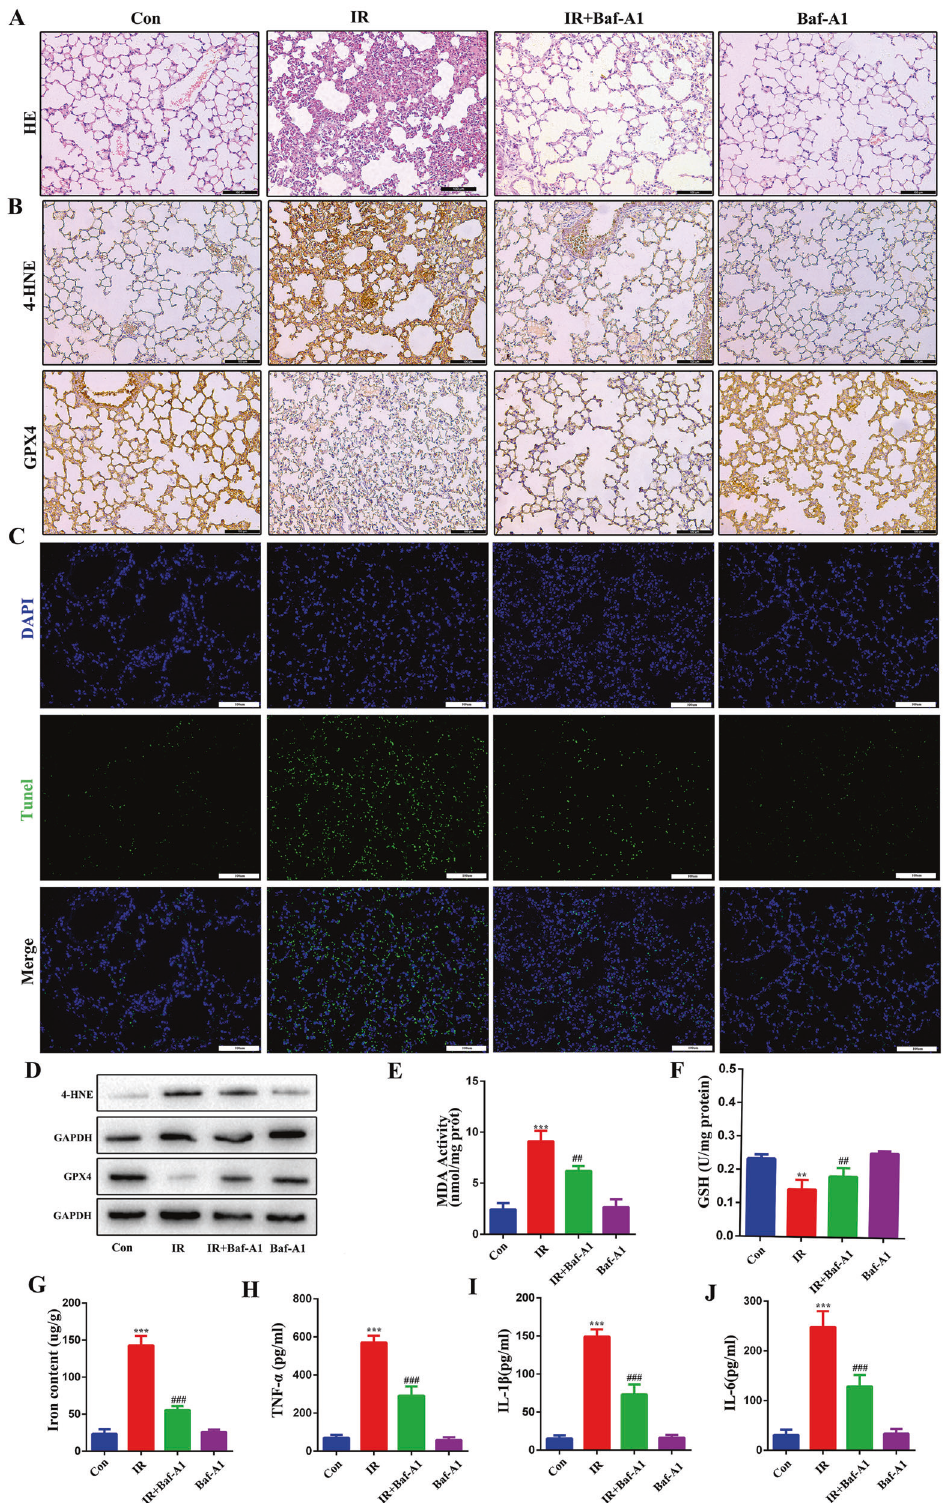
Fig. 7 Lysosomal inhibitor of Baf-A1 alleviates radiation-induced ferroptosis in mice. The mice were treated with Baf-A1 (10 µM) or DMSO. A H&E staining of lung. B Representative IHC images of GPX4 and 4HNE in the lung sections. C TUNEL assay of lung sections. D The levels of 4HNE and GPX4 in the lung tissues. E – G Activities of MDA, GSH, and iron content in the mouse lung tissues. H – J Concentrations of TNF- α ( H ), IL-1 β ( I ), and IL-6 ( J ) in serum. #/ * P < 0.05, ##/ ** P < 0.01, ###/ *** P < 0.001, # vs. IR group; * vs. control